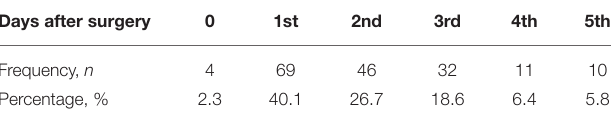
TABLE 2 | The univariate analysis of post-operative delirium.